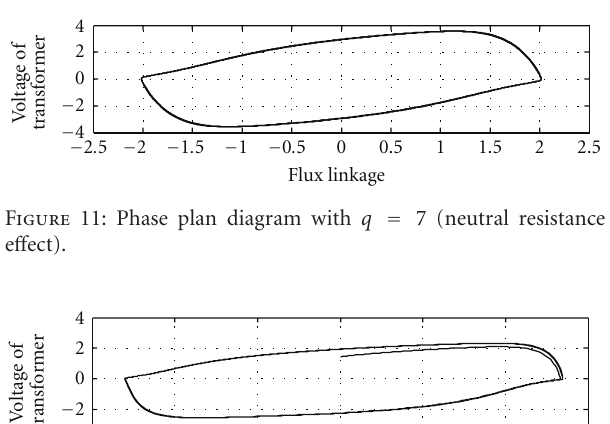
Figure 14: Bifurcation diagram with q = 11 (neutral resistance e ff